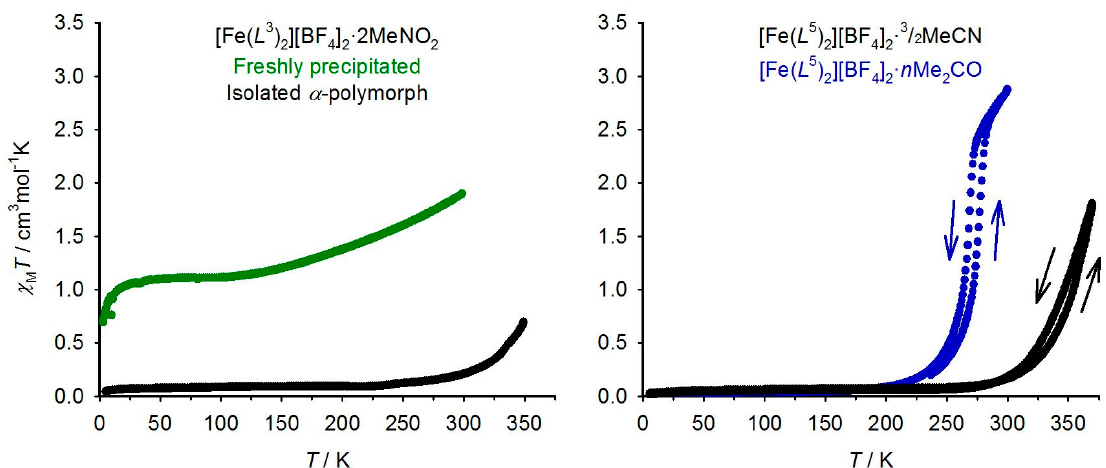
Figure 6. Variable temperature magnetic susceptibility data for different preparations of